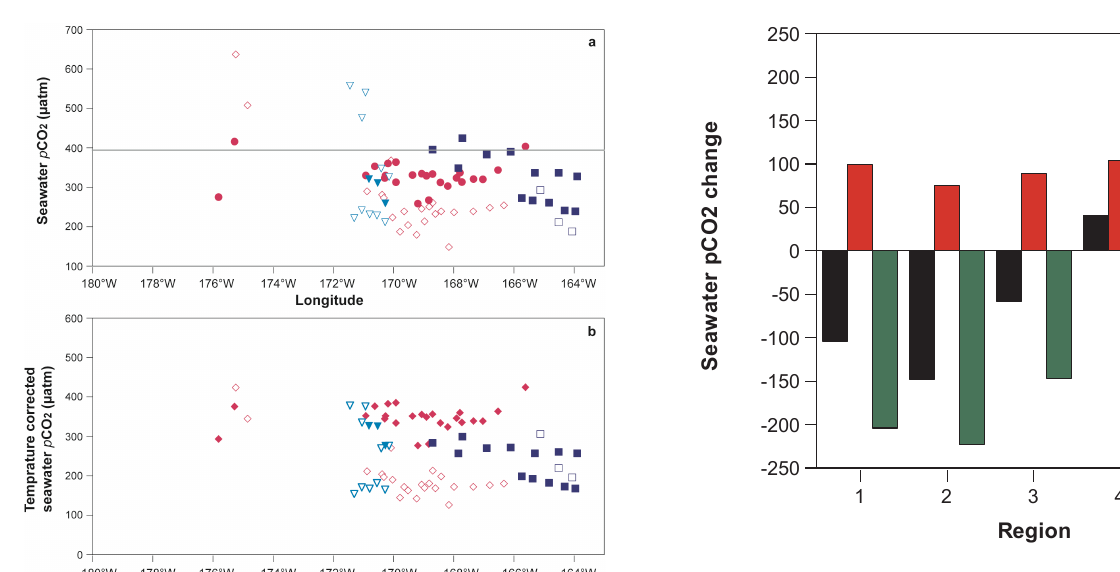
( µ moles kg -1 ) for the 3